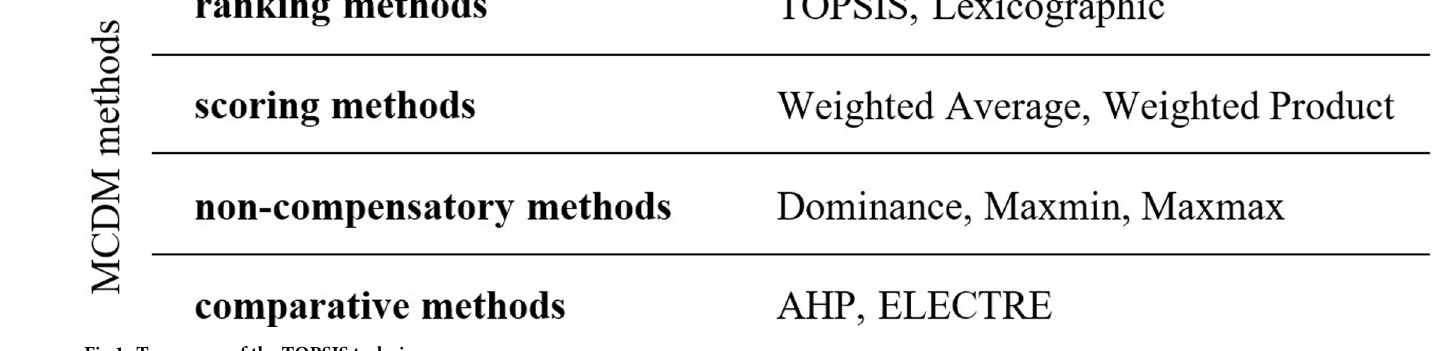
Fig 1. Taxonomy of the TOPSIS technique.